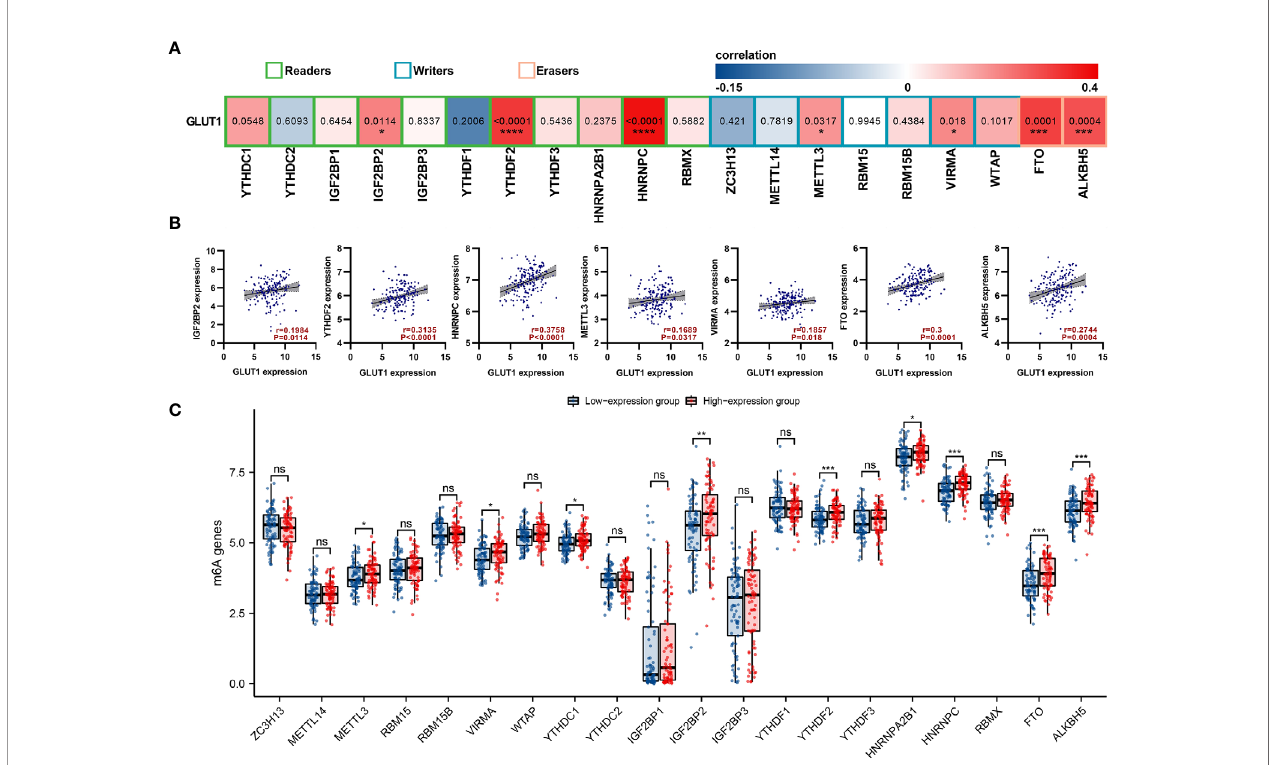
FIGURE 4 | Correlations of GLUT1 expression with m6A related genes in esophageal carcinoma (ESCA). (A) TCGA cohort analyzed the correlation between the expression level of GLUT1 and the expression of m6A-related genes in ESCA. (B) Draw a scatter plot to show the correlation between GLUT1 and m6A related genes. Related m6A related genes include IGF2BP2, YTHDF2, HNRNPC, METTL3, VIRMA, FTO and ALKBH5. (C) The differential expression of m6A related genes in the high and low GLUT1 expression groups in ESCA tumor samples. * p < 0.05; ** p < 0.01; *** p < 0.001; **** p < 0.0001. ns, not signi fi